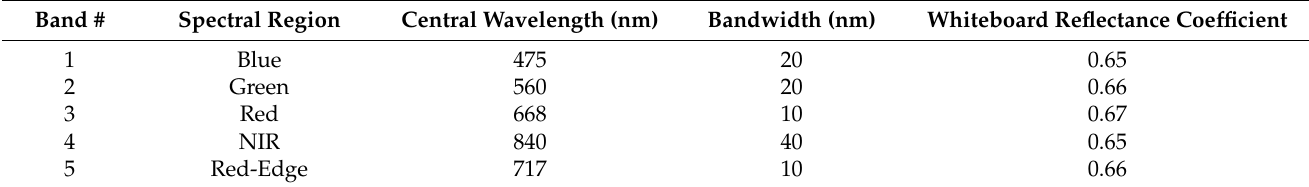
Whiteboard reflectance coefficients provided by the manufacturers of the Micasense ® RedEdge camera [41]. reflectance white panel having an area of 225 cm 2 (15 cm × 15 cm). The panel was placed over the top of the canopy 1.5 m from the camera (Figure 3). The reflectance value of the panel varied as a function of the band (Table 1).